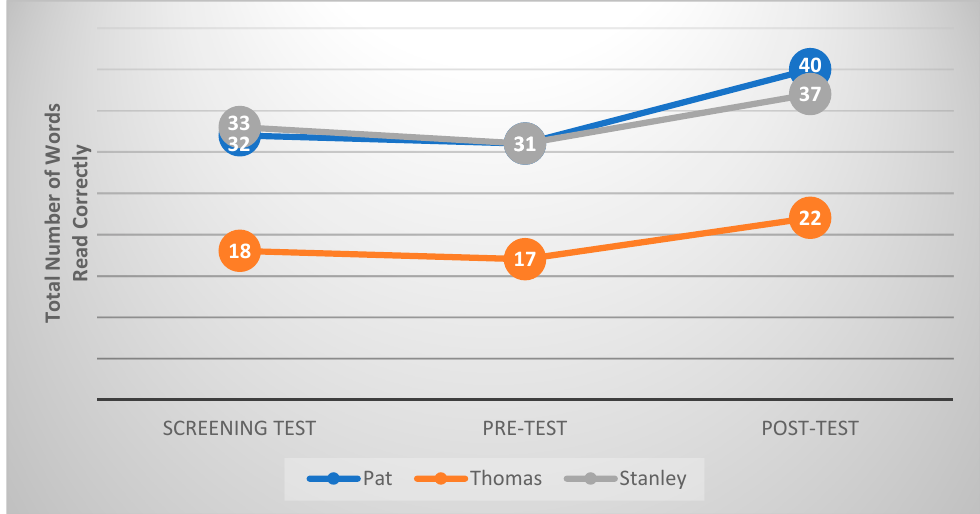
Figure 1. The reading speed by each child within 45 s across all time points.